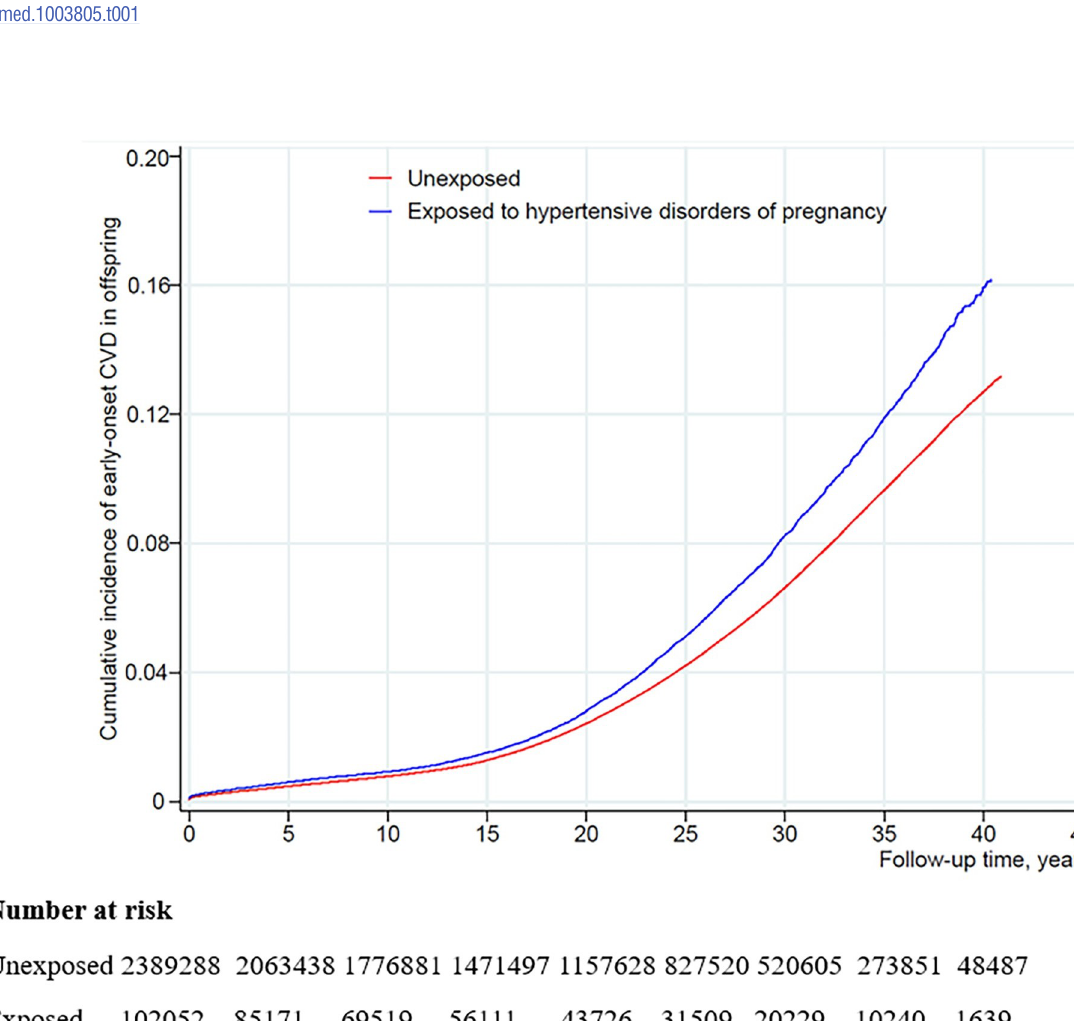
Fig 2. Cumulative incidence of early-onset CVD among offspring exposed and unexposed to HDP. CVD AU : AnabbreviationlisthasbeencompiledforthoseusedinFig 2 : Pleaseverifythatallentriesarecorrect : , cardiovascular disease; HDP, hypertensive disorders of